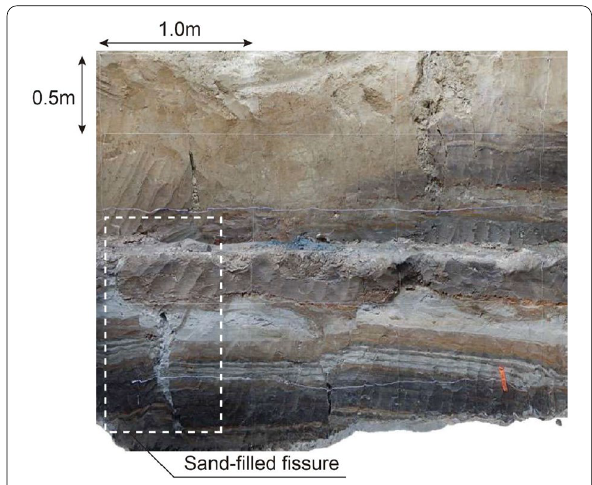
Fig. 3 A sand-filled fissure that appeared on a wall of Trench-1 excavated by Angster et al.